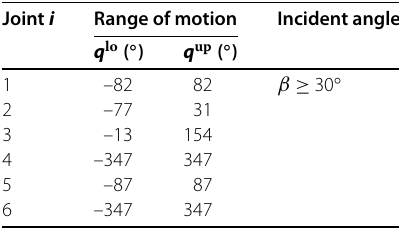
Table 4 Range of motion of joints and admitted incident angle between sensor surface and laser beam Joint i Range of motion Incident angle q lo ( ◦ ) q up ( ◦ ) 1 –82 82 β ≥ 30 ◦ 2 –77 31 3 –13 154 4 –347 347 5 –87 87 6 –347